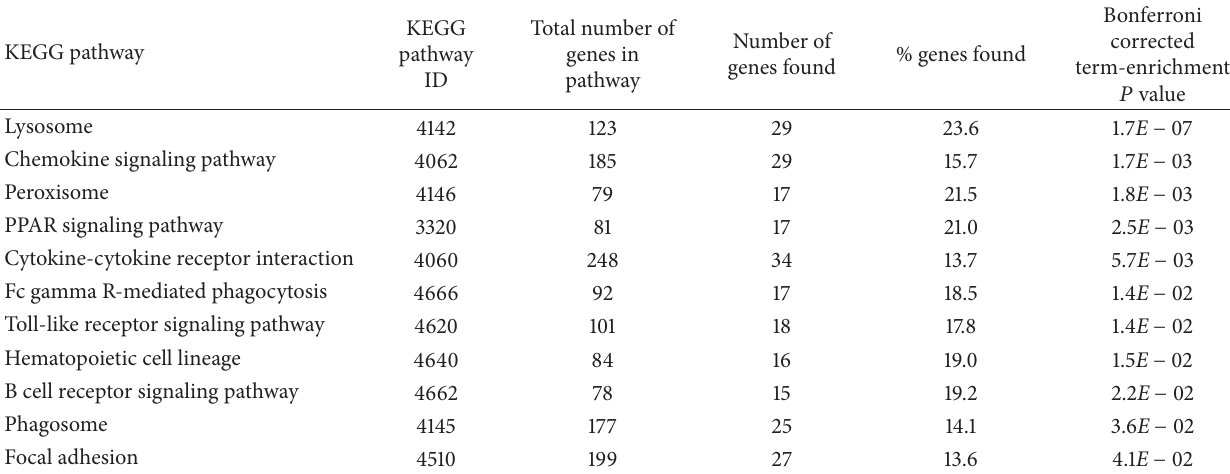
Table 1: KEGG pathway enrichment of 1607 regulated transcripts in CD8 − lung DCs.